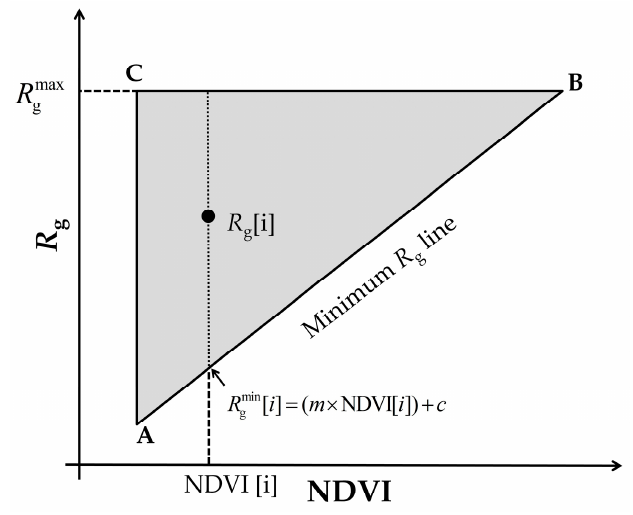
Figure 3. Schematic of the DiSoRa model.